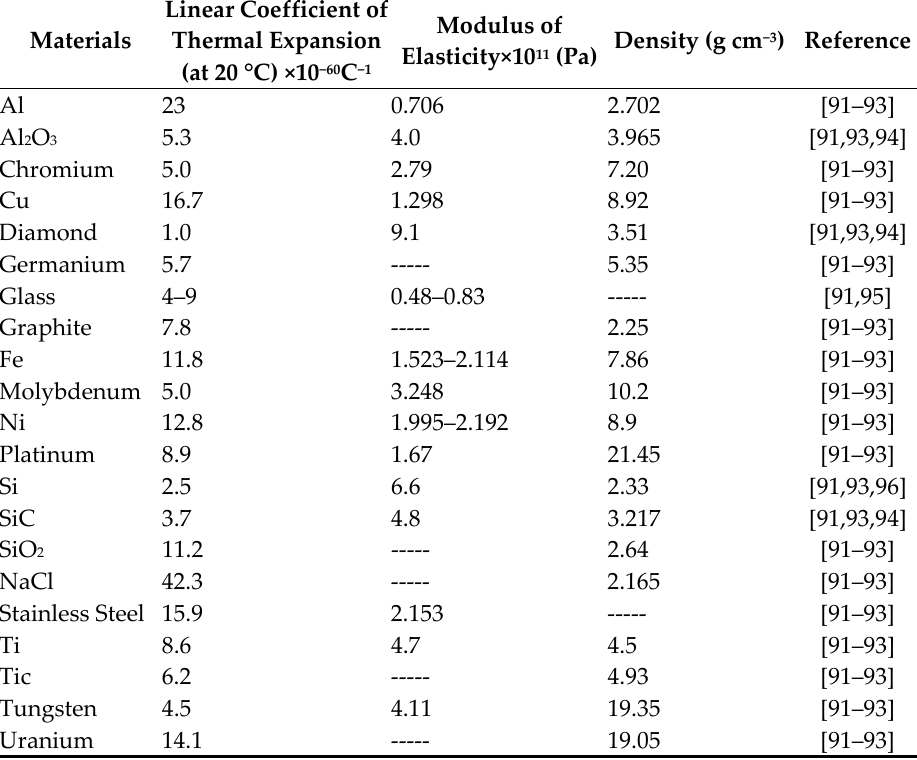
Table 2. Mechanical and thermal properties of various materials.